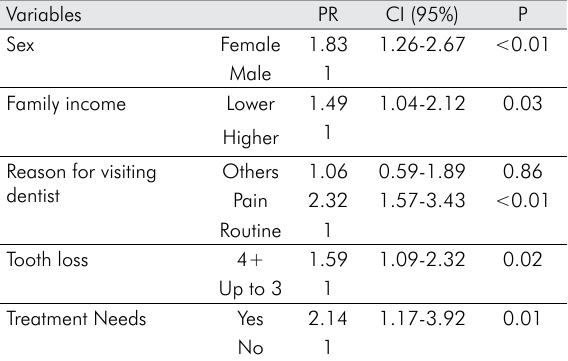
Table 4. Poisson regression model for impacts on